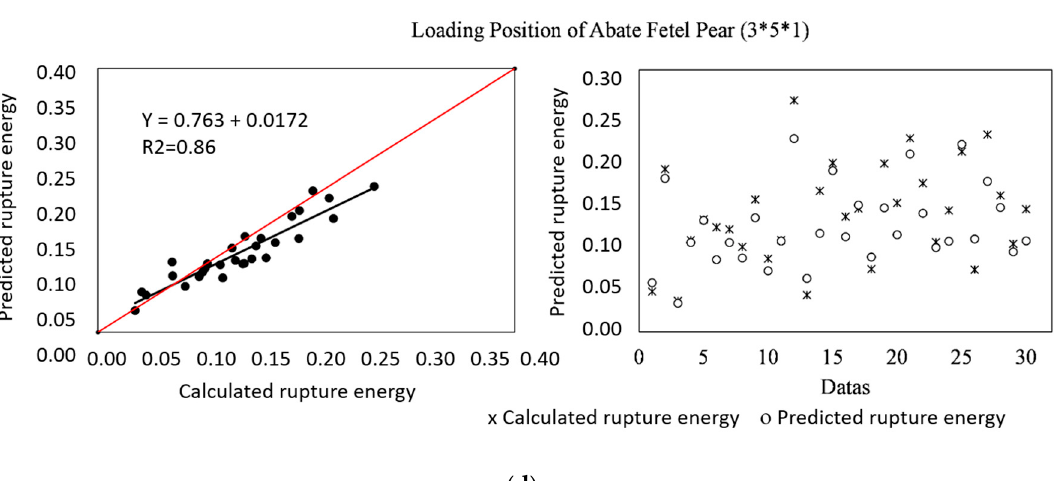
Figure 3. Scatter plots between calculated and predicted rupture energy results according to ANN1 ( a ) storage duration of Deveci pear; ( b ) loading position of Deveci pear; ( c ) storage duration of Abate Fetel pear, and ( d ) loading position of Abate Fetel pear.